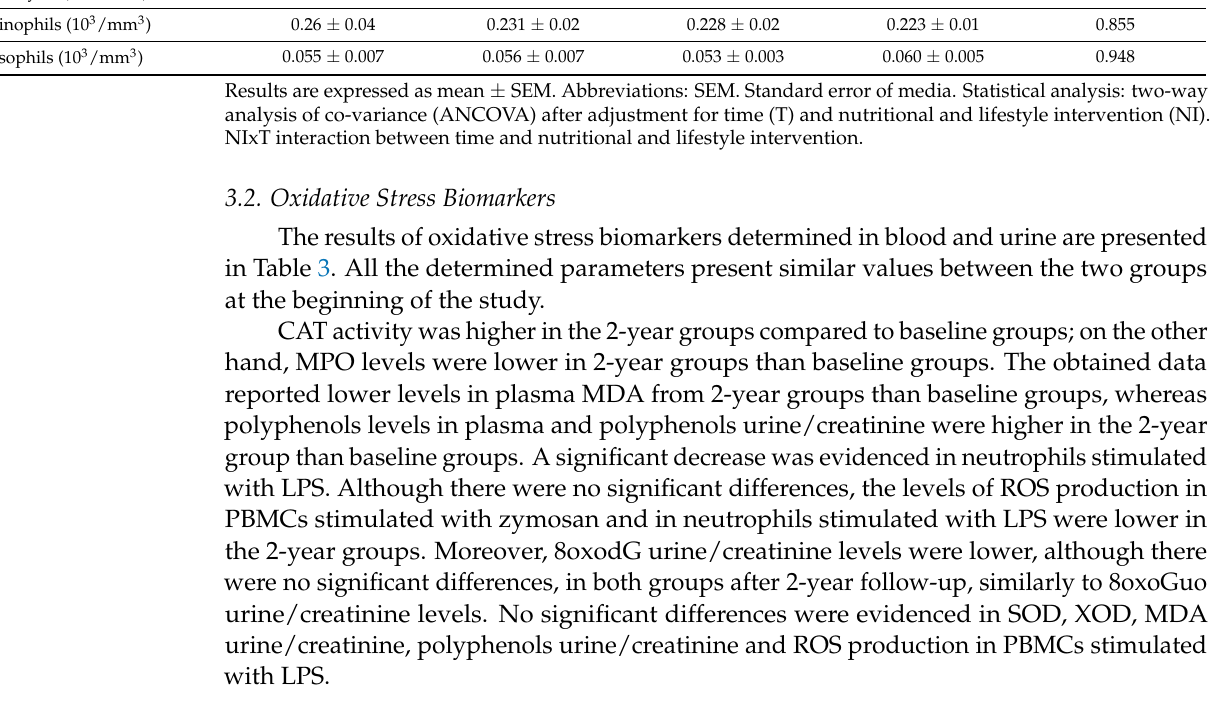
Table 3. Biomarkers of participants according to nutritional and lifestyle intervention